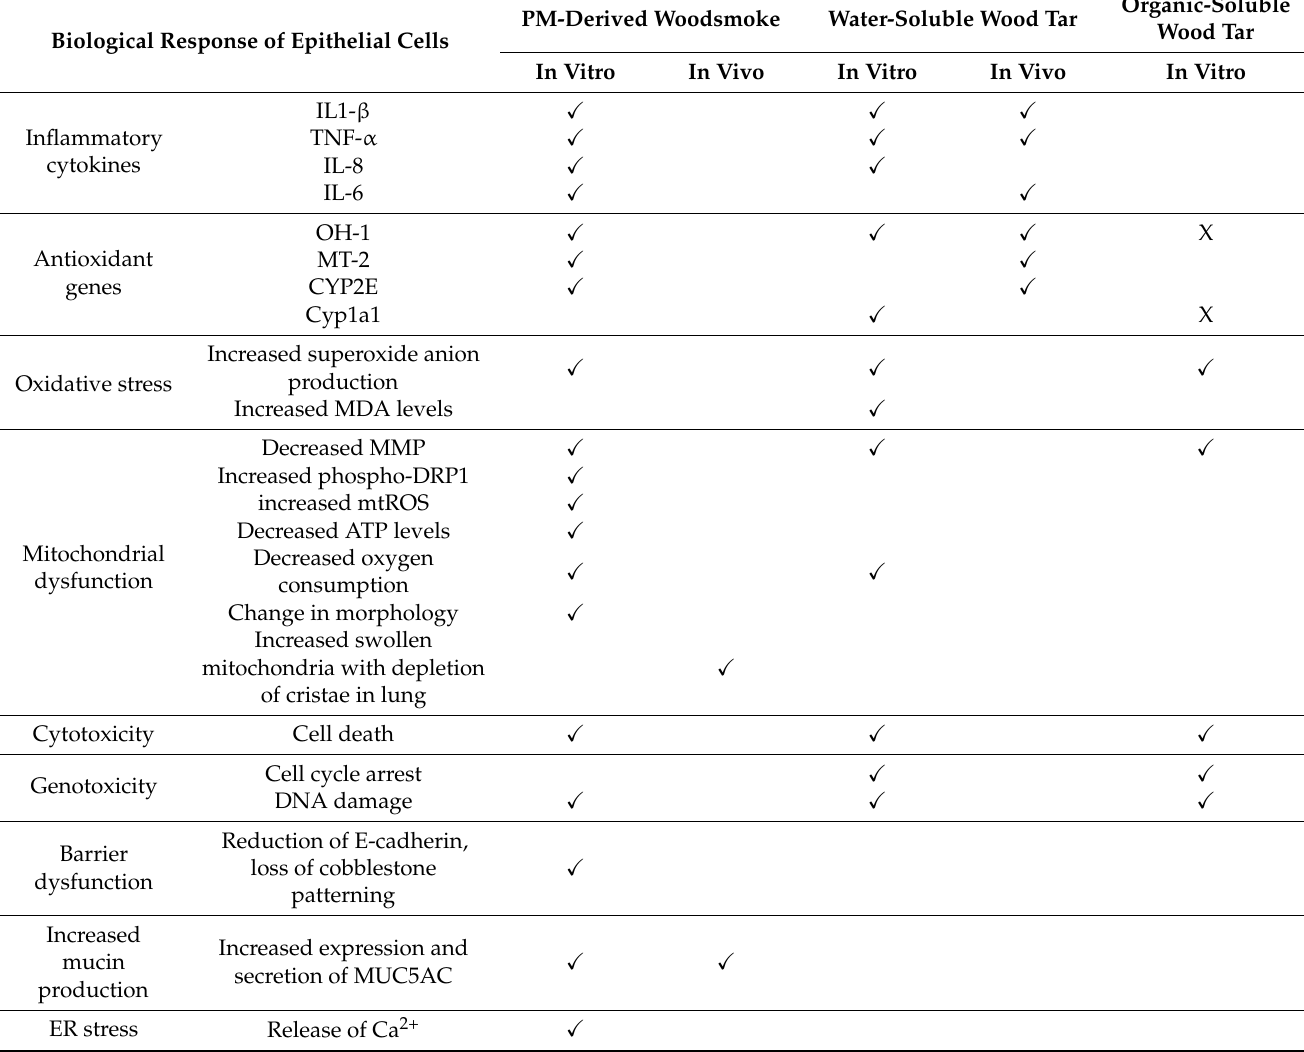
Table 3. Summary of the in vitro and in vivo biological responses of the human airway epithelium to woodsmoke